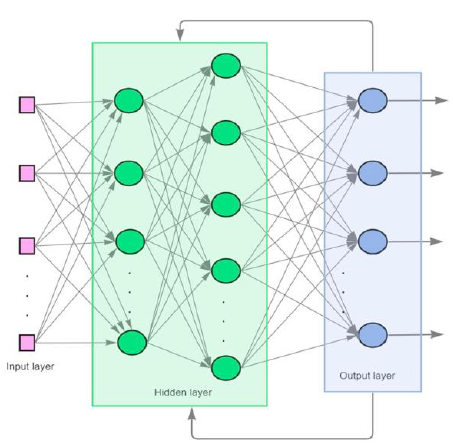
Figure 11. RNN model.